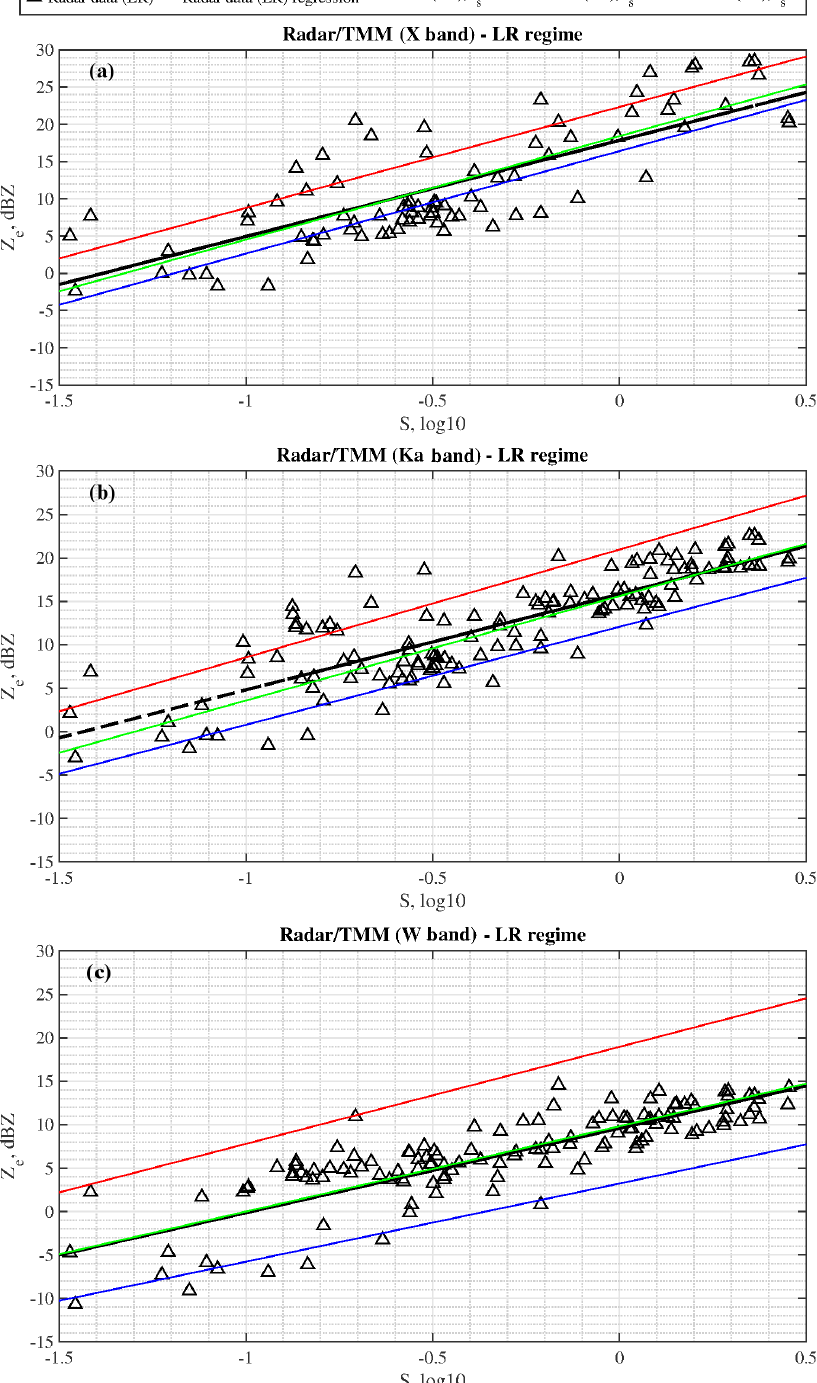
Figure 4. Case for lightly rimed (LR) snowfall: (a) X-, (b) Ka- and (c) W-band results. Scatter plot of the equivalent radar reflectivity, measured by ARM radars (black triangles), with respect to the snow rates, S, measured by PIP. The black line represents the Z e – S empirical least-squares relationship as listed in Table 2. Z e – S parametric relations, derived from TMM-based simulations, are also shown for different aspect ratios (0.2, 0.6, 1) using red, green and blue lines as listed in Table